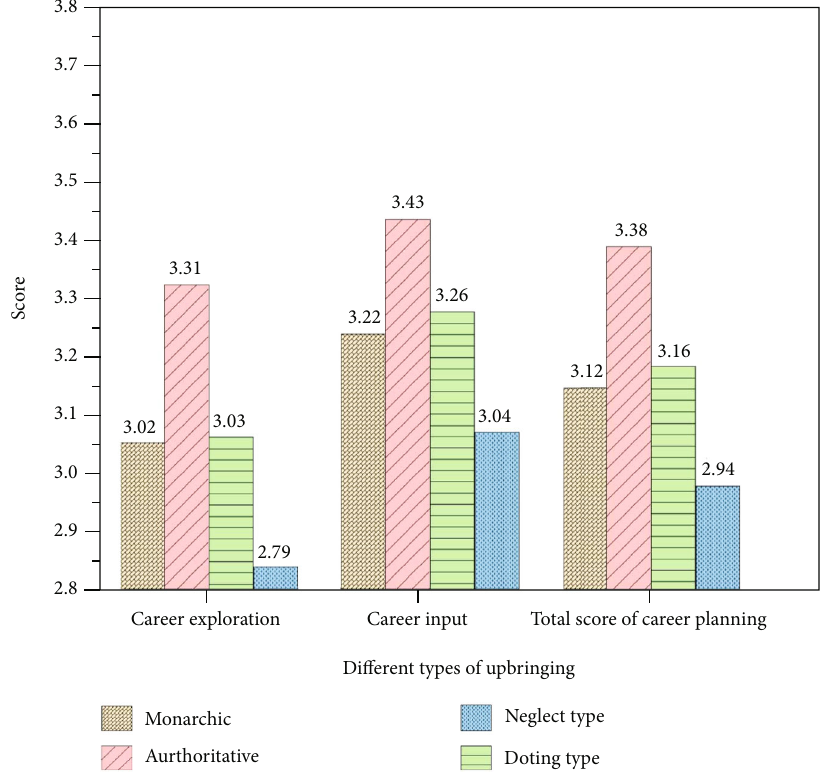
Figure 8: Di ff erence analysis of career planning under di ff erent parenting